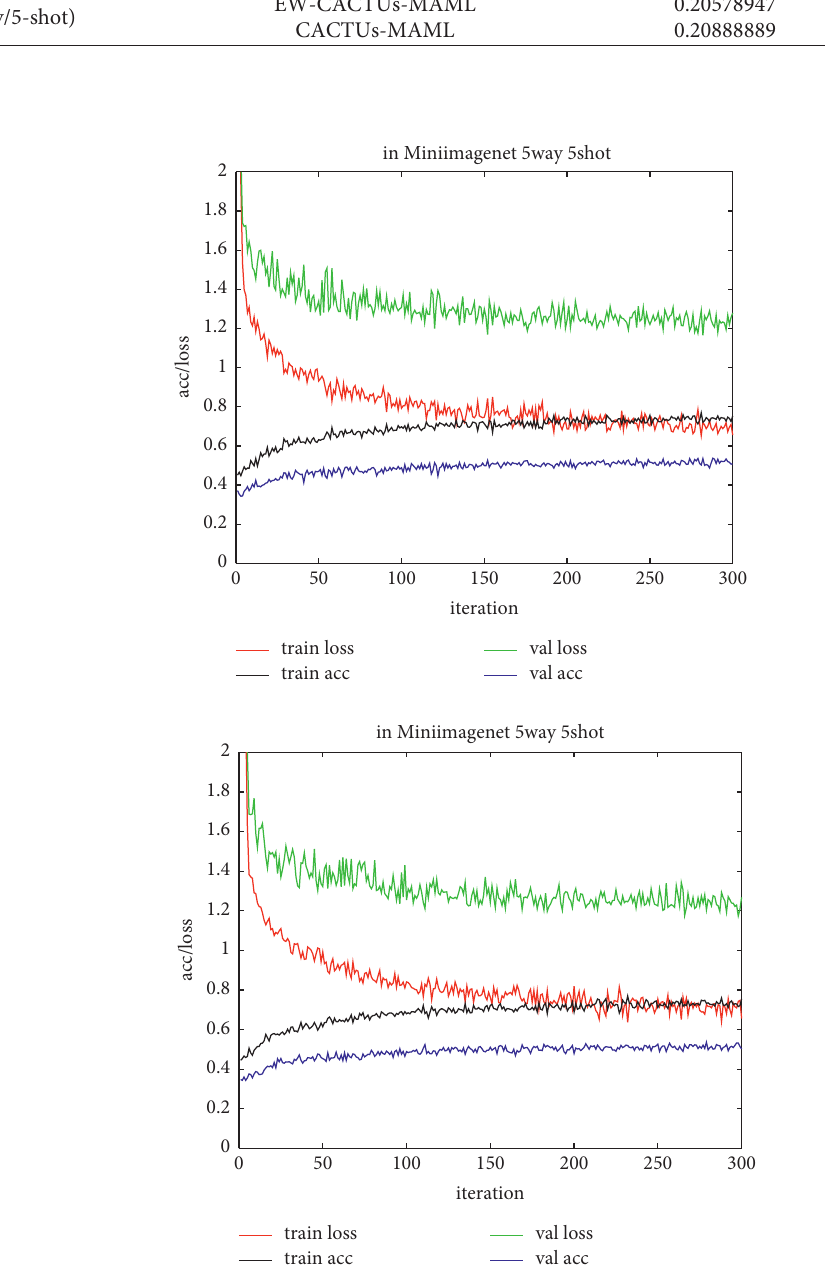
Figure 7: Performance of EW-CACTUs-ProtoNets and CACTUs-ProtoNets.